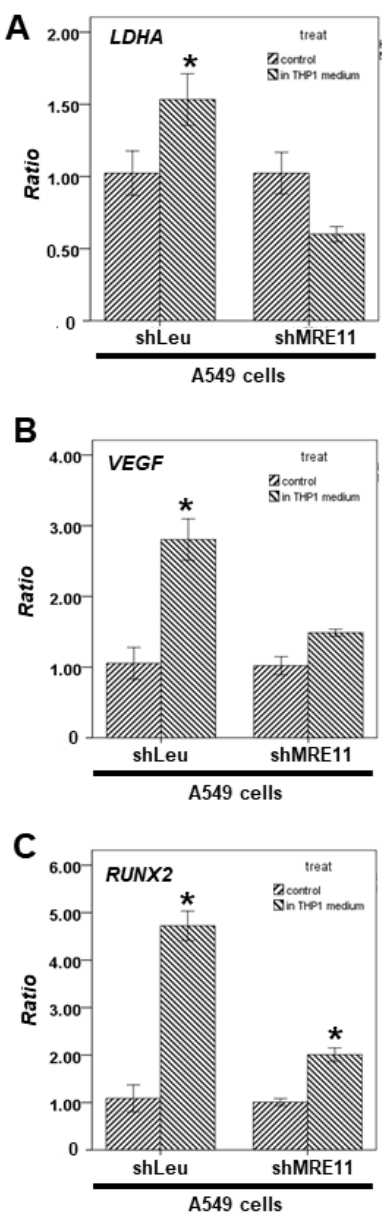
Figure 4. The effect of MRE11 on STAT3 ′ s downstream genes treated with a conditional medium of macrophages. ( A – C ) Total mRNA was extracted from A549 shLeu and A549 shMRE11 cells after treatment with or without the conditional medium of THP-1 for 24 h. The coding regions of human LDHA , VEGF, and RUNX2 were used as probes for real-time polymerase chain reaction analysis. (Error bars = mean ± S.E.M. Asterisks (*) mark samples significantly different from the DMSO group with p < 0.05.).